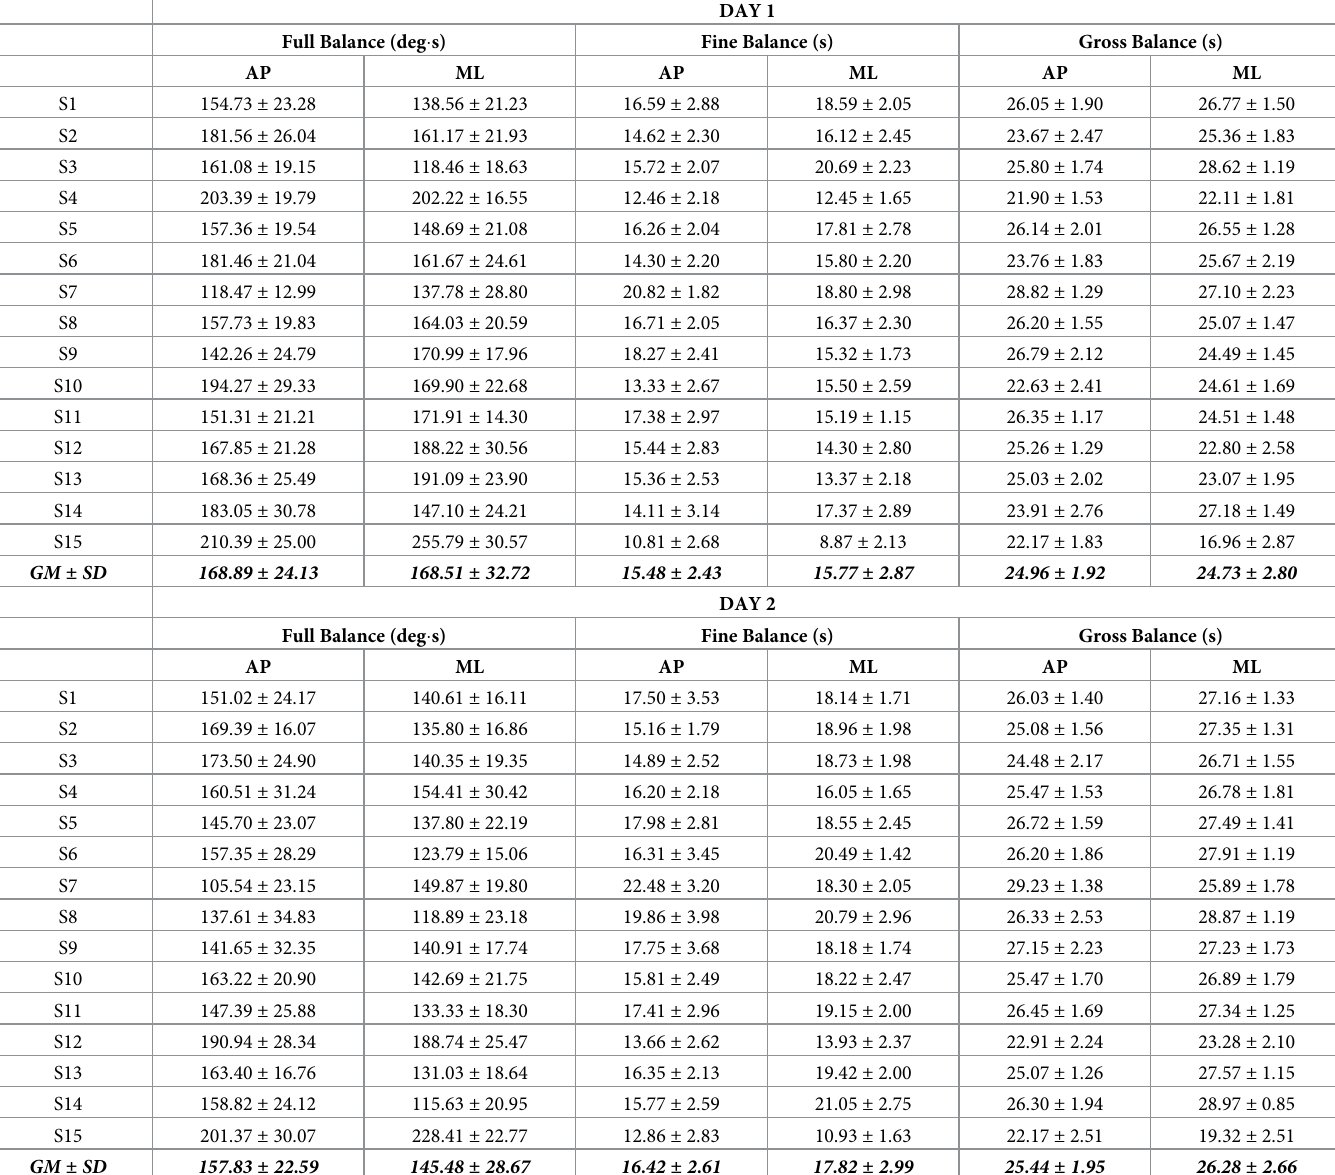
Table 2. Mean values, group means (GM), and standard deviations (SDs) of the kinematic parameters (Full balance, Fine Balance, and Gross Balance) during the unstable board test (DAY 1) and retest (DAY 2)